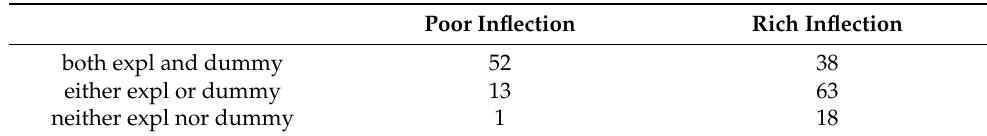
Table 6. Presence of expletives and dummies in dialects with poor and rich verbal inflection (dataset: Manzini and Savoia